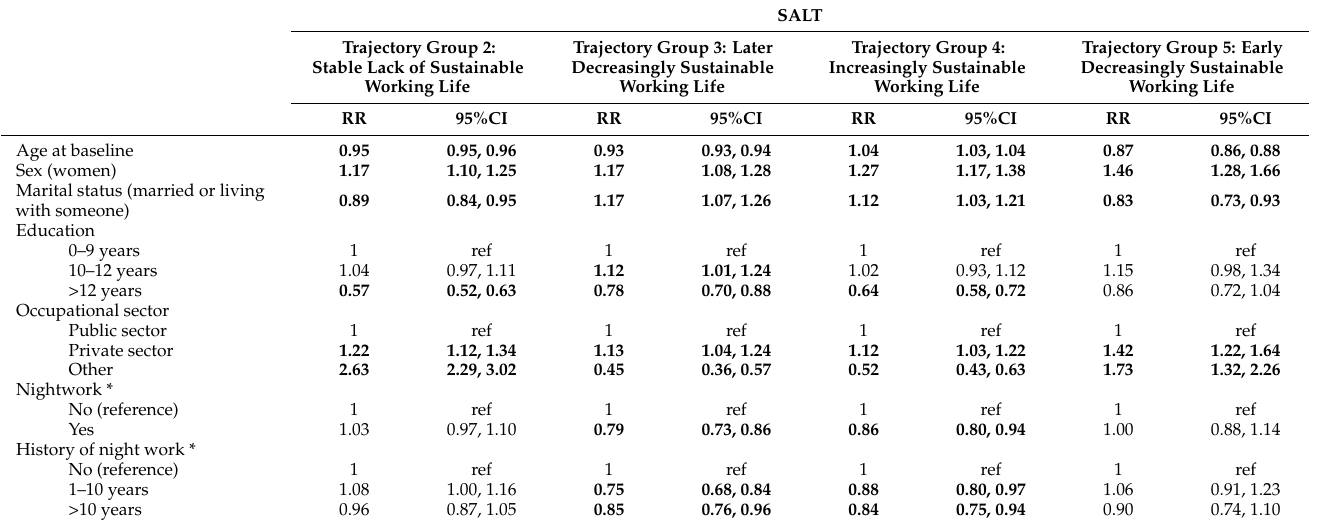
Table 3. Relative-risk ratios (RRs) with 95% confidence intervals (Cis) for sociodemographic factors in relation to sustainable working life trajectory groups in the SALT cohort (with trajectory group 1 (sustainable working life) as a reference). SALT Working